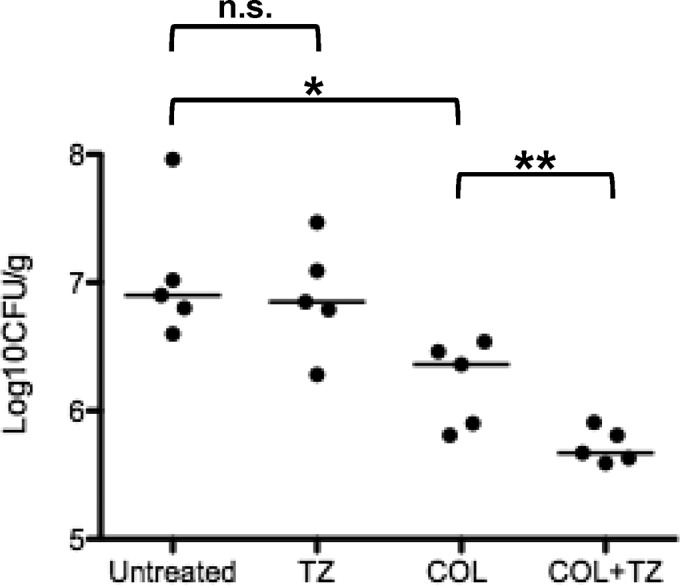
Murine model of A. baumannii pneumonia in BALB/c mice (5 per group) treated for 24 h with COL, tazobactam (TZ), both COL and tazobactam, or saline and enumeration of bacteria in harvested lungs (CFU per gram). Horizontal bars represent the medians for each group. *, P = 0.008 versus the control; **, P = 0.047 versus COL; n.s., not significant.